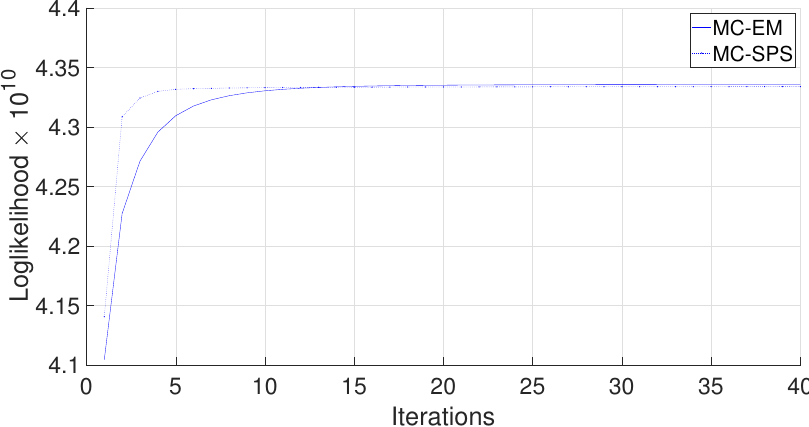
Figure 2. Loglikelihood vs. iteration number for MC-EM and MC-SPS.